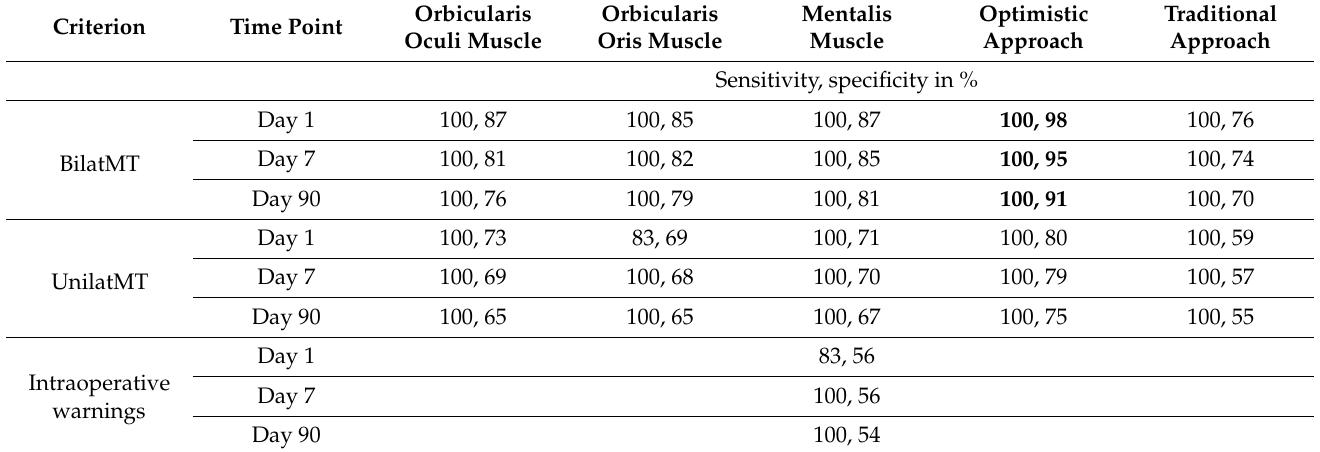
Table 4. Risk stratification.